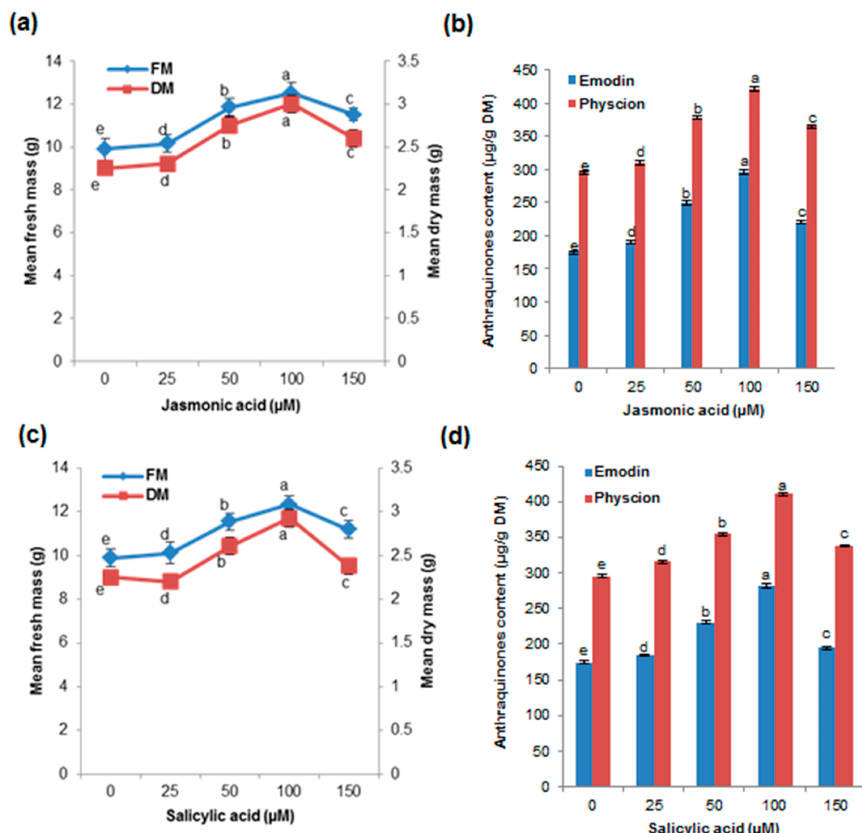
Figure 3. Effects of jasmonic acid (JA) and salicylic acid (SA) on biomass accumulation and anthraquinone (emodin and physcion) production in cell suspension cultures of P. multiflorum : ( a , b ) JA; ( c , d ) SA. Means ± standard deviation of three replicates followed by the same letters are not significantly different according to DMRT at p ≤ 0.05.